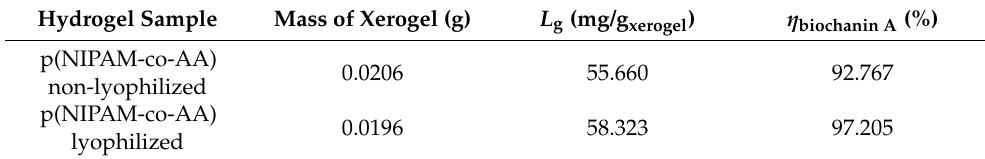
Table 6. The masses of xerogels and incorporated biochanin A ( L g ) and loading efficiency ( η ). Hydrogel